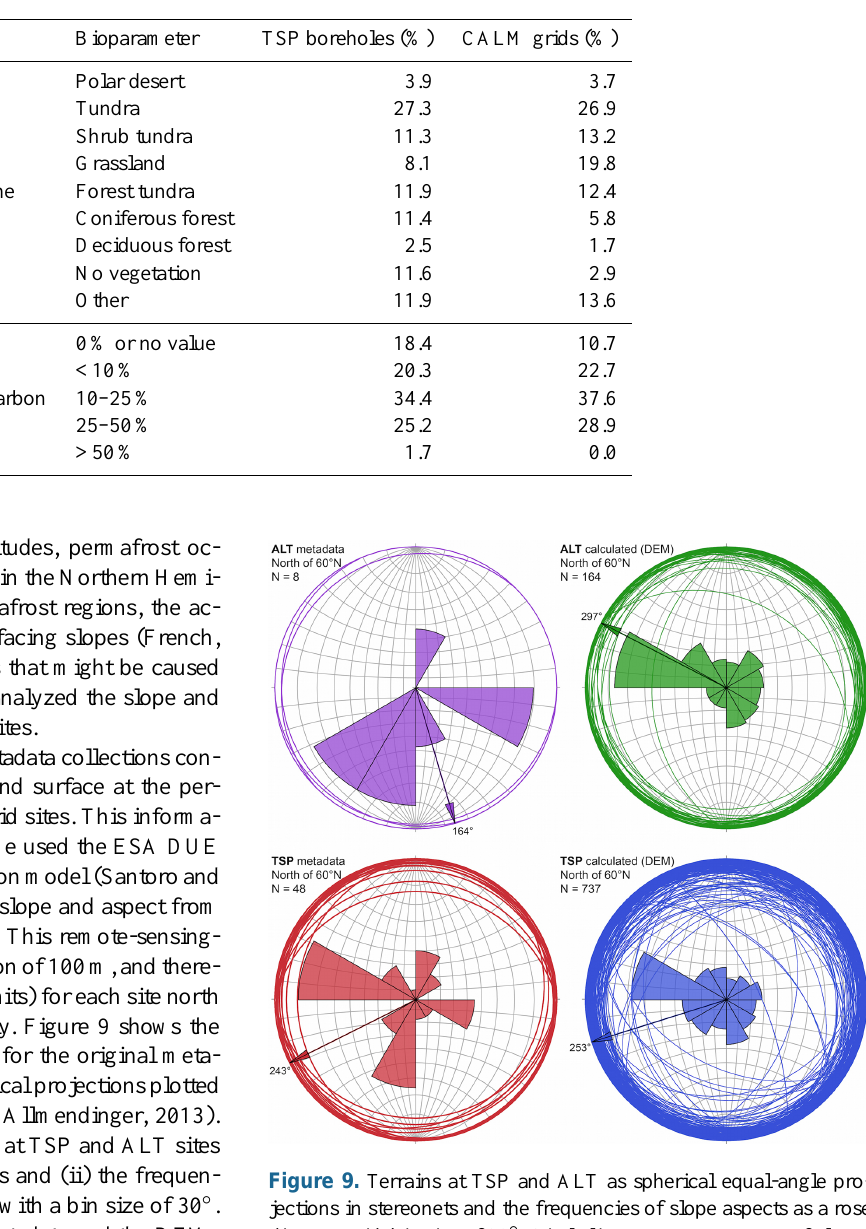
Table 2. Representation of bioparameters within the borehole and active layer monitoring site distributions. Distribution of soil organic carbon contents in the top 200cm from Northern Circumpolar Soil Carbon Database (Hugelius et al., 2013). Vegetation zones taken from the standardized GTN-P metadata.